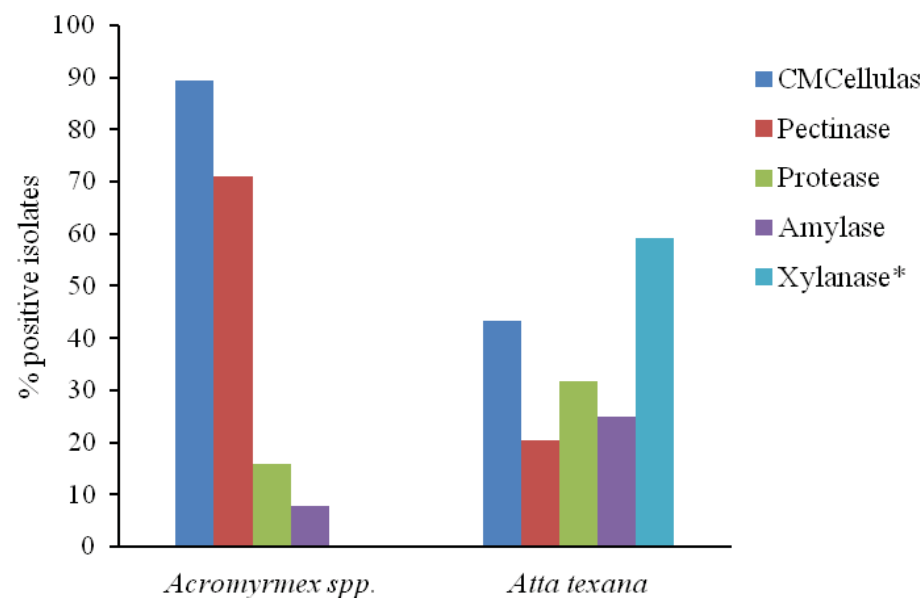
Figure 1. Proportion of hydrolytic yeast isolates recovered from fungus gardens of the leaf-cutting ant genera Acromyrmex (n = 38 yeast isolates) and Atta (n = 44 isolates). For details check Tables 1 and 2. Xylanase activity was not determinate for yeasts recovered from Acromyrmex